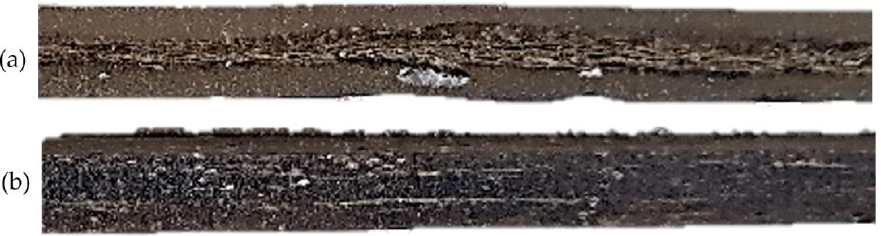
Figure 13. Comparison of specimens (side view) obtained by the sandwich method ( a ) and interme- diate plate method ( b ) after testing.